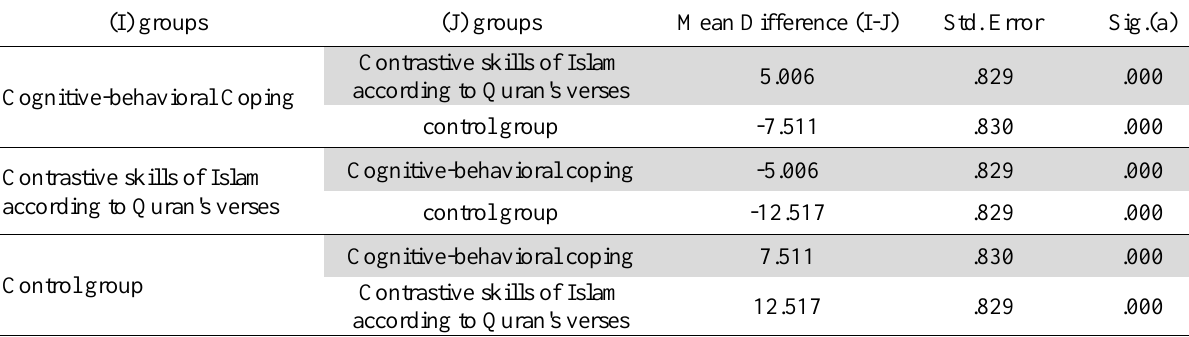
The level of anxiety in post